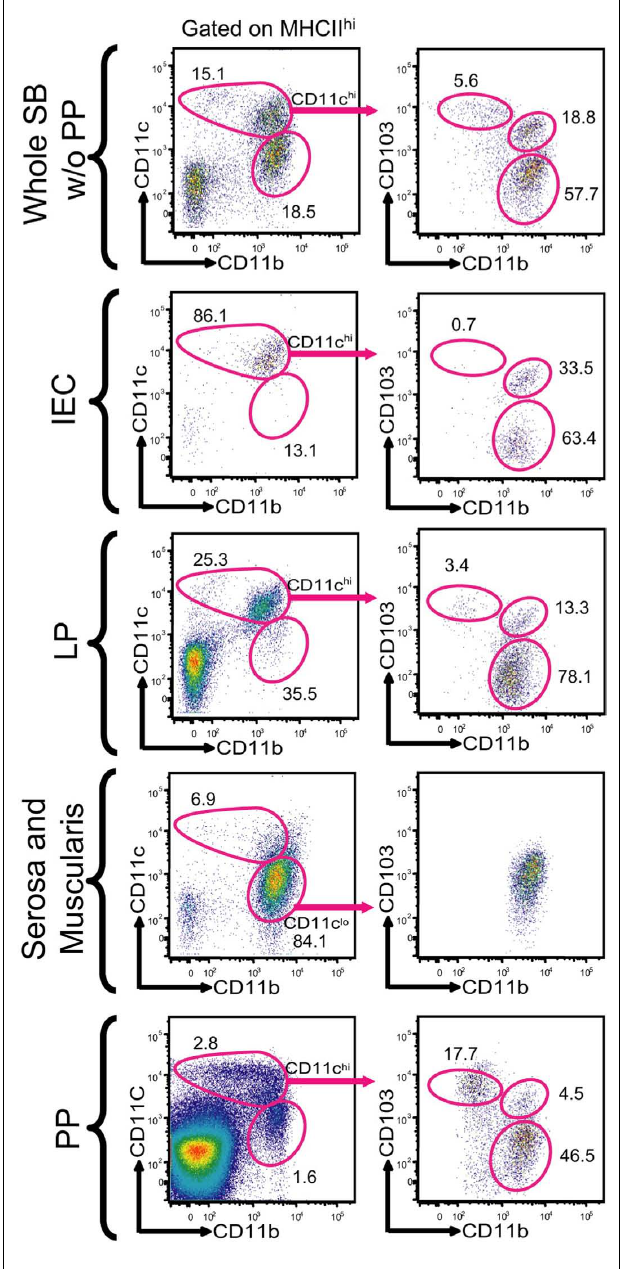
FIGURE 1 | Characterization of CD103 + DC subsets in the small bowel. With permission (Bogunovic et al., 2009). Single cell suspensions were prepared from various anatomical locations found throughout the small bowel, these included the IEC compartment, lamina propria (LP), serosa with the intestinal muscularis, and PP.The populations were gated on DAPI negative, CD45 positive, MHC Class II high and CD11c high .The CD11c high population was further characterized on the basis of CD103 and CD11b